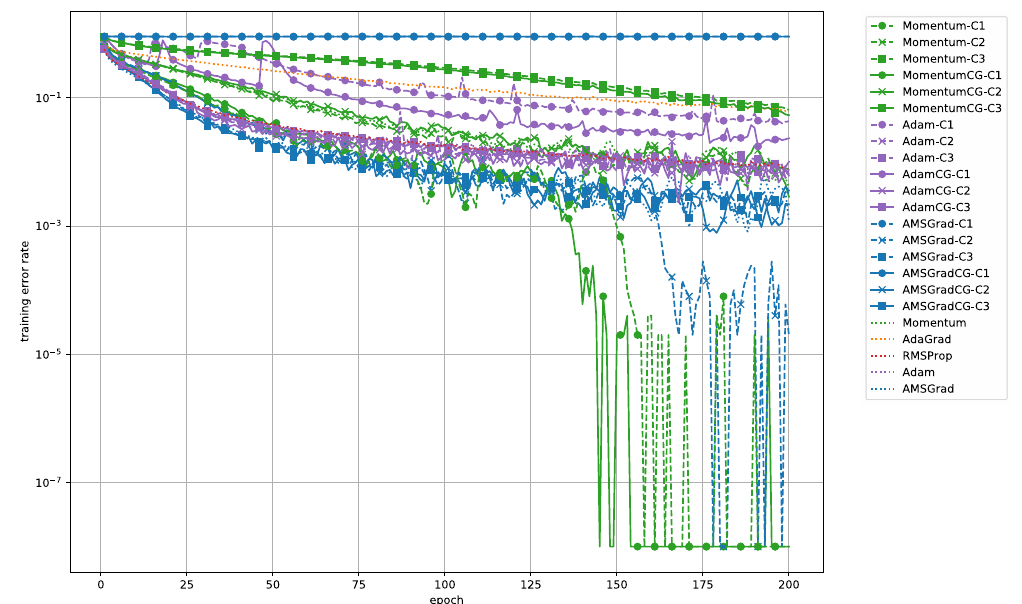
Figure 2. Classification error rate versus number of epochs on the CIFAR-10 dataset for training (constant).